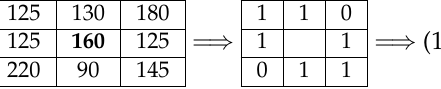
Figure 7. Illustration of the census